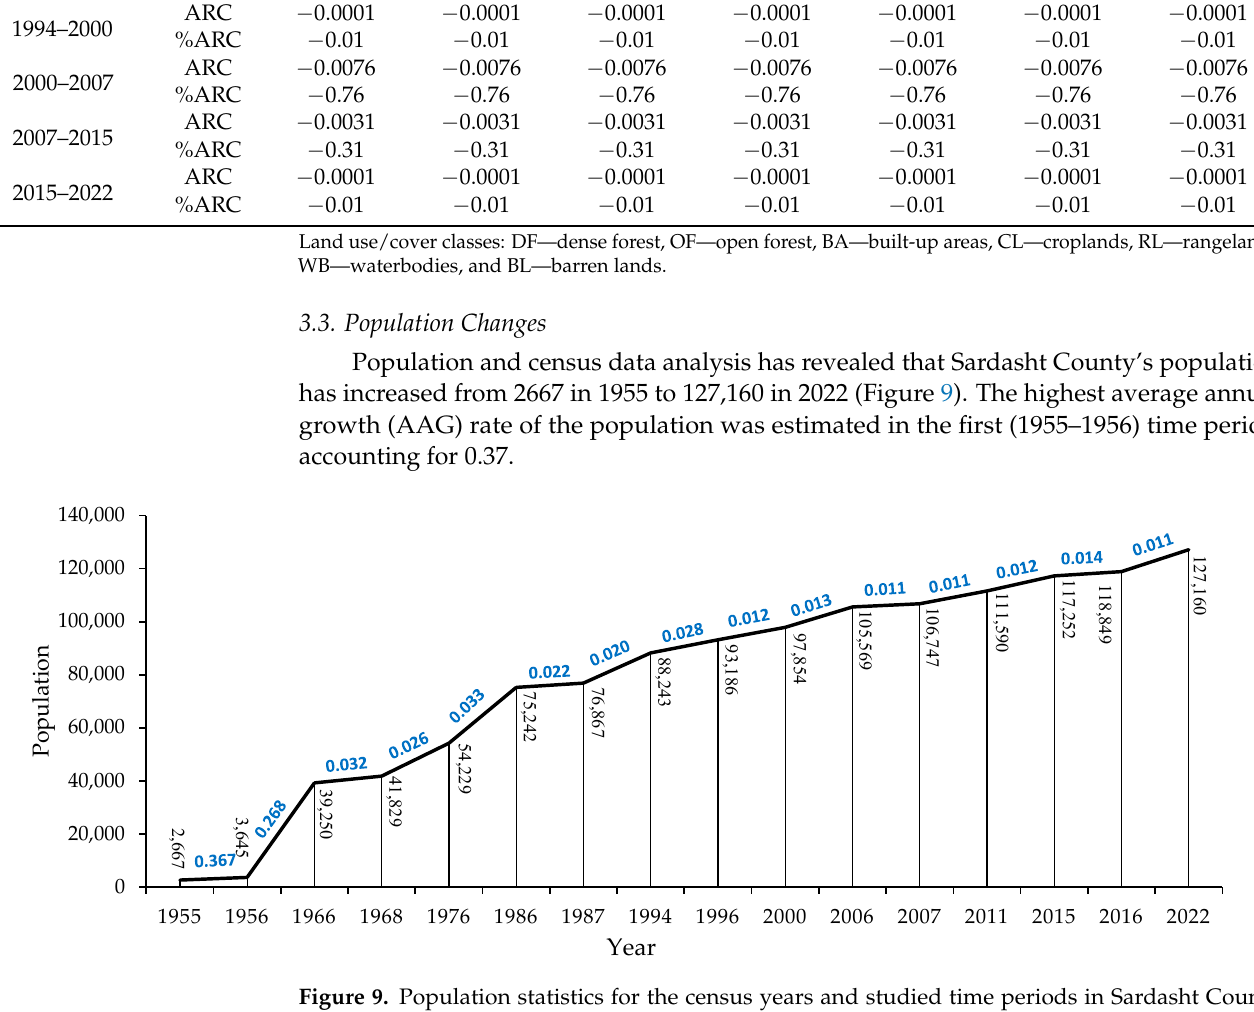
Figure 9. Population statistics for the census years and studied time periods in Sardasht County. Numbers in bold and blue color indicate average annual growth (AAG) rate of population between different years.